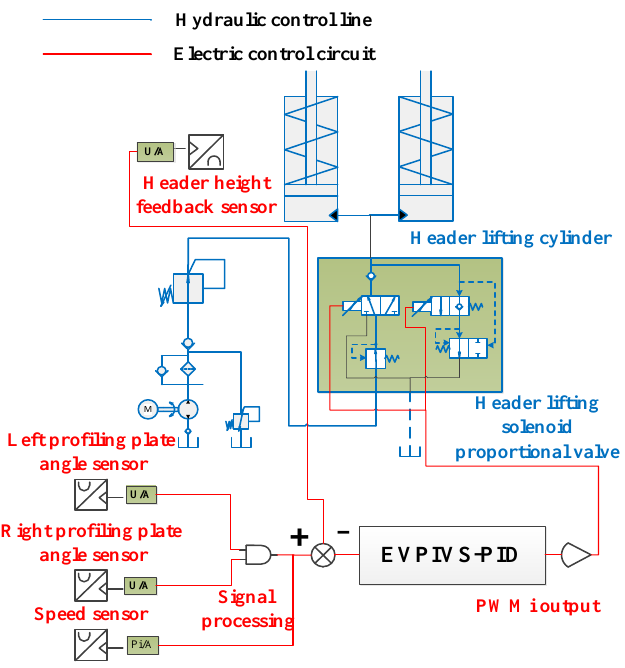
Figure 16. EVPIVS-PID control algorithm structure principle. The blue area in the Figure 17 is the hydraulic system part, and the red area is the electronic control system part. The on-board diesel engine drives the hydraulic pump to